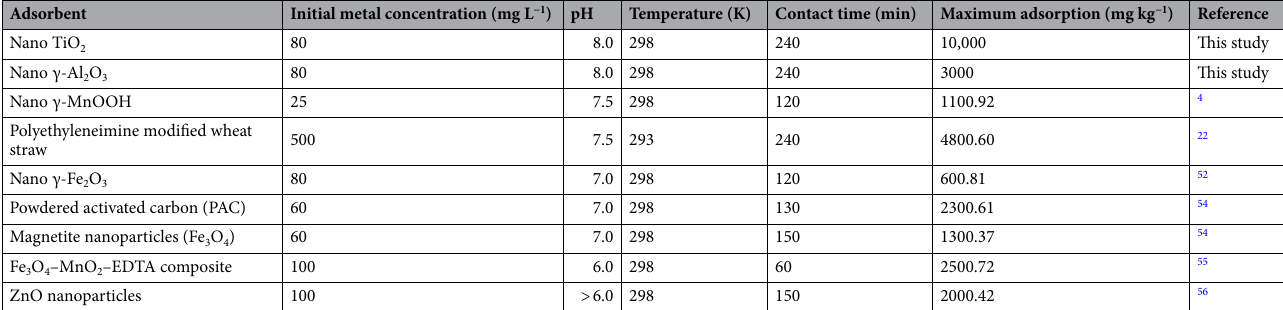
Table 7. Copper (Cu(II)) adsorption with different